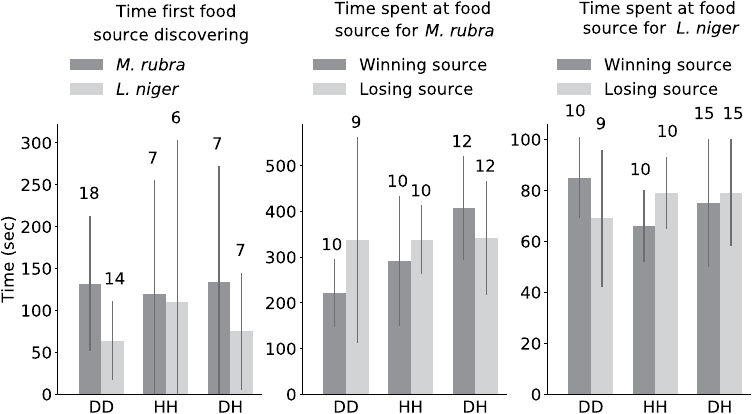
Figure 3. Discovery of and time spent at food sources. Mean and standard deviation; numbers above bars = N.